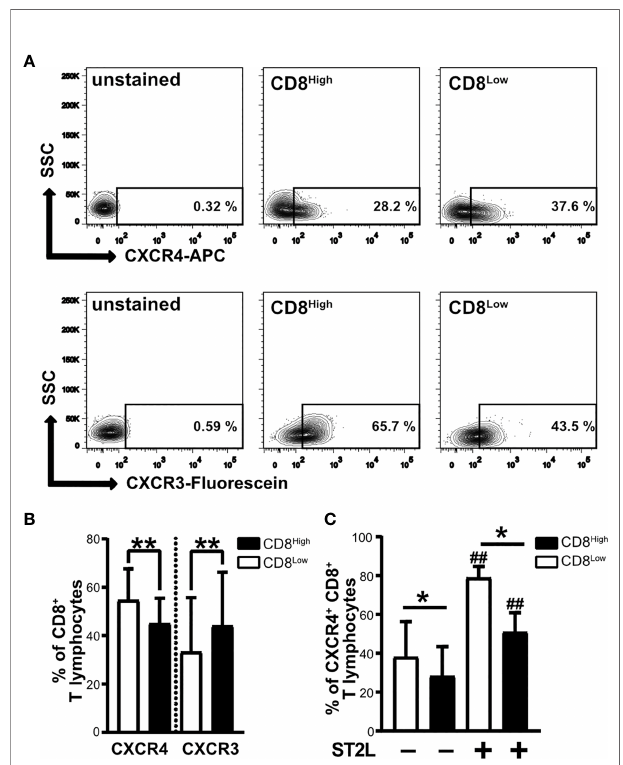
FIGURE 4 | CXCR4 chemokine receptor expression is higher on CD8 Low ST2L + T lymphocytes, whereas CXCR3 dominates on CD8 High T lymphocytes. Surface protein expression of CXCR4 and CXCR3 on CD8 Low and CD8 High subpopulations. CD8 + T lymphocytes were puri fi ed from human PBMC and cultivated for 40 h without serum. CD8 + T lymphocyte populations were gated as CD8 High (black bars) or CD8 Low (white bars) and the expression of CXCR4 (APC), CXCR3 (Fluorescein) or ST2L (FITC) was analyzed by fl ow cytometry. (A) Representative contour plots comparing the percentages of CXCR4 + and CXCR3 + of CD8 Low and CD8 High T lymphocyte subpopulations, respectively. (B) Data are presented as mean ± SD from n = 10 donors of at least three independently performed experiments. **p < 0.01, using Wilcoxon matched pairs signed rank test. (C) Data are presented as mean ± SD from n = 7 donors of three independently performed experiments. ##p < 0.01 for comparisons of ST2L + and ST2L – subpopulations using Friedman test with Dunn ’ s post-test, *p ≤ 0.05, comparisons between groups using Wilcoxon matched-pairs signed rank